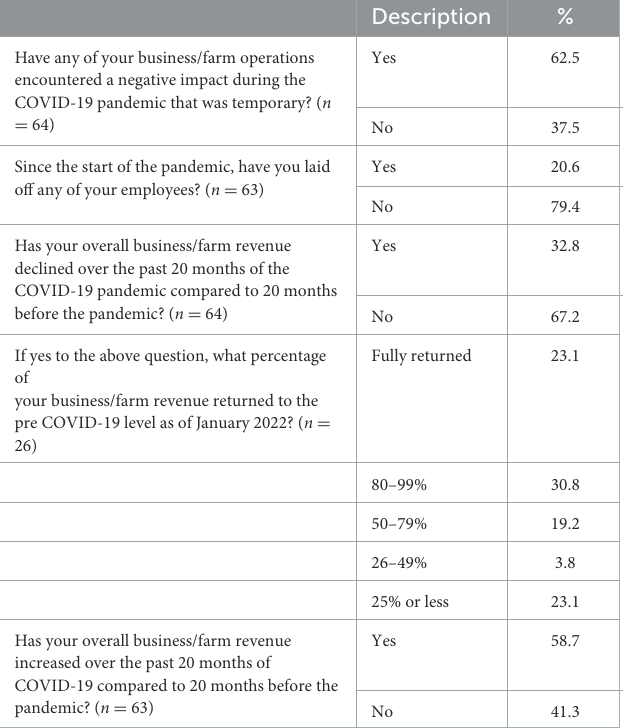
TABLE 5 The effect of COVID-19 on SFSCs.